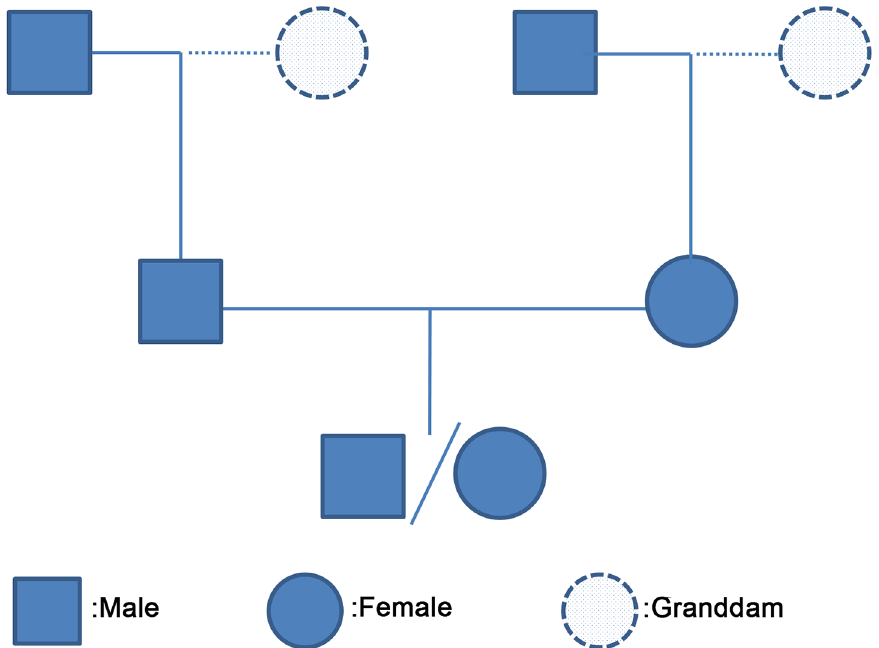
Fig 1. A three-generation family used for phasing haplotypes and inferring crossovers. We extracted 185,917 three-generation families, where the offspring, two parents and two grandsires were genotyped, from a large pedigree of Holstein cattle with over half million genotyped cattle maintained in USDA-AGIL (S1, S2 and S3 Tables). Depending on the number of genotyped granddams, we collected 67,690, 76,318 and 41,909 three-generation families respectively with two, one and zero genotyped